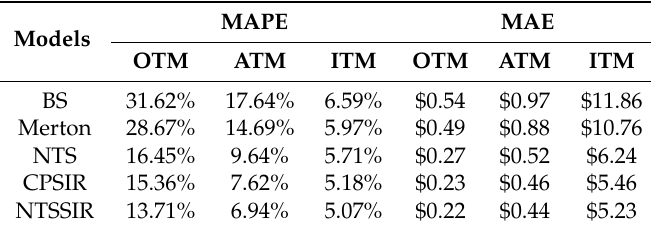
Table 2. In-sample pricing errors. For a given model, we compute the price of each option on on 15 April 2020, using the parameters estimated in Table 1. The group under the heading MAPE reports the sample average of the absolute difference between the market price and the model price for each option in a given moneyness category; the group under the heading MAE reports the sample average of the value derived through dividing the MAE by the market price.